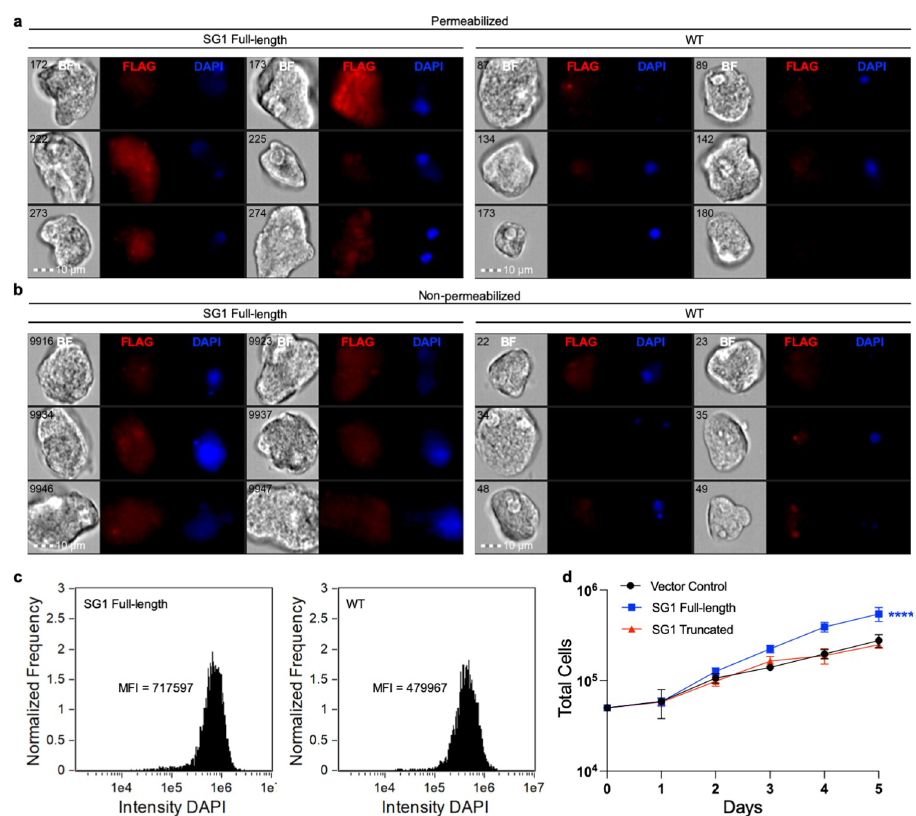
Samples were permeabilized prior to antibody staining. Six random cells are shown for each condition. Shown from left to right are bright field images (BF), rabbit anti-FLAG antibody staining (FLAG, red), and DAPI staining